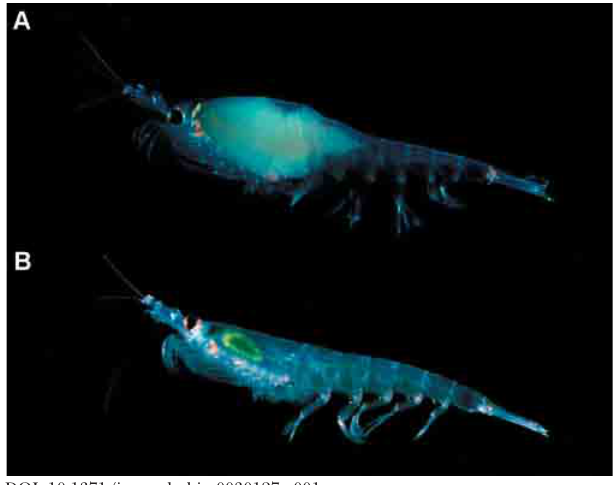
Figure 1. Krill Abundance Has Dropped 80% in 30 Years (A) This gravid female is nearly ready to release her eggs. (B) Krill feed on phytoplankton, indicated by the green color in this specimen’s digestive